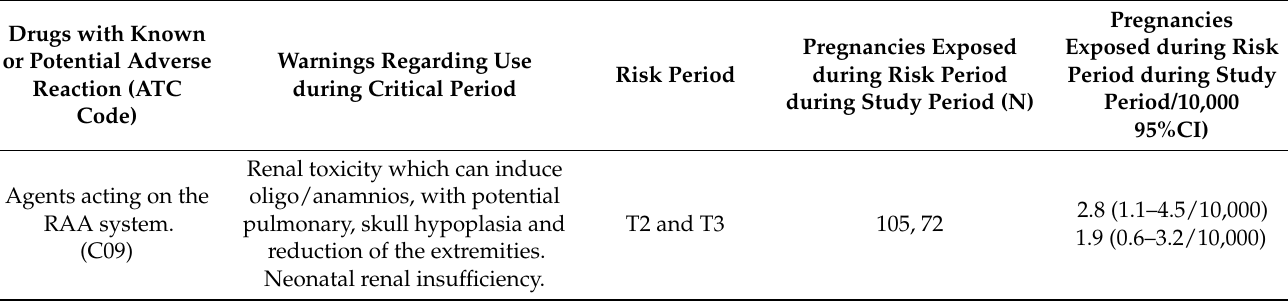
Table 4. Exposure to drugs with known or potential adverse reaction during trimester 2/3 (weighted